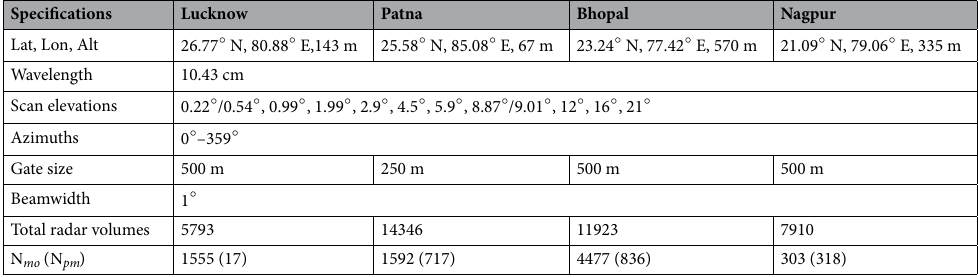
Table 1. Geographical details and technical specifications of S-band DWRs located over the Indian subcontinent. The abbreviations Lat, Lon, and Alt refer to latitude, longitude, and altitude respectively. Here, N N mo and pm indicate the number of storms detected in monsoon and pre-monsoon seasons respectively.